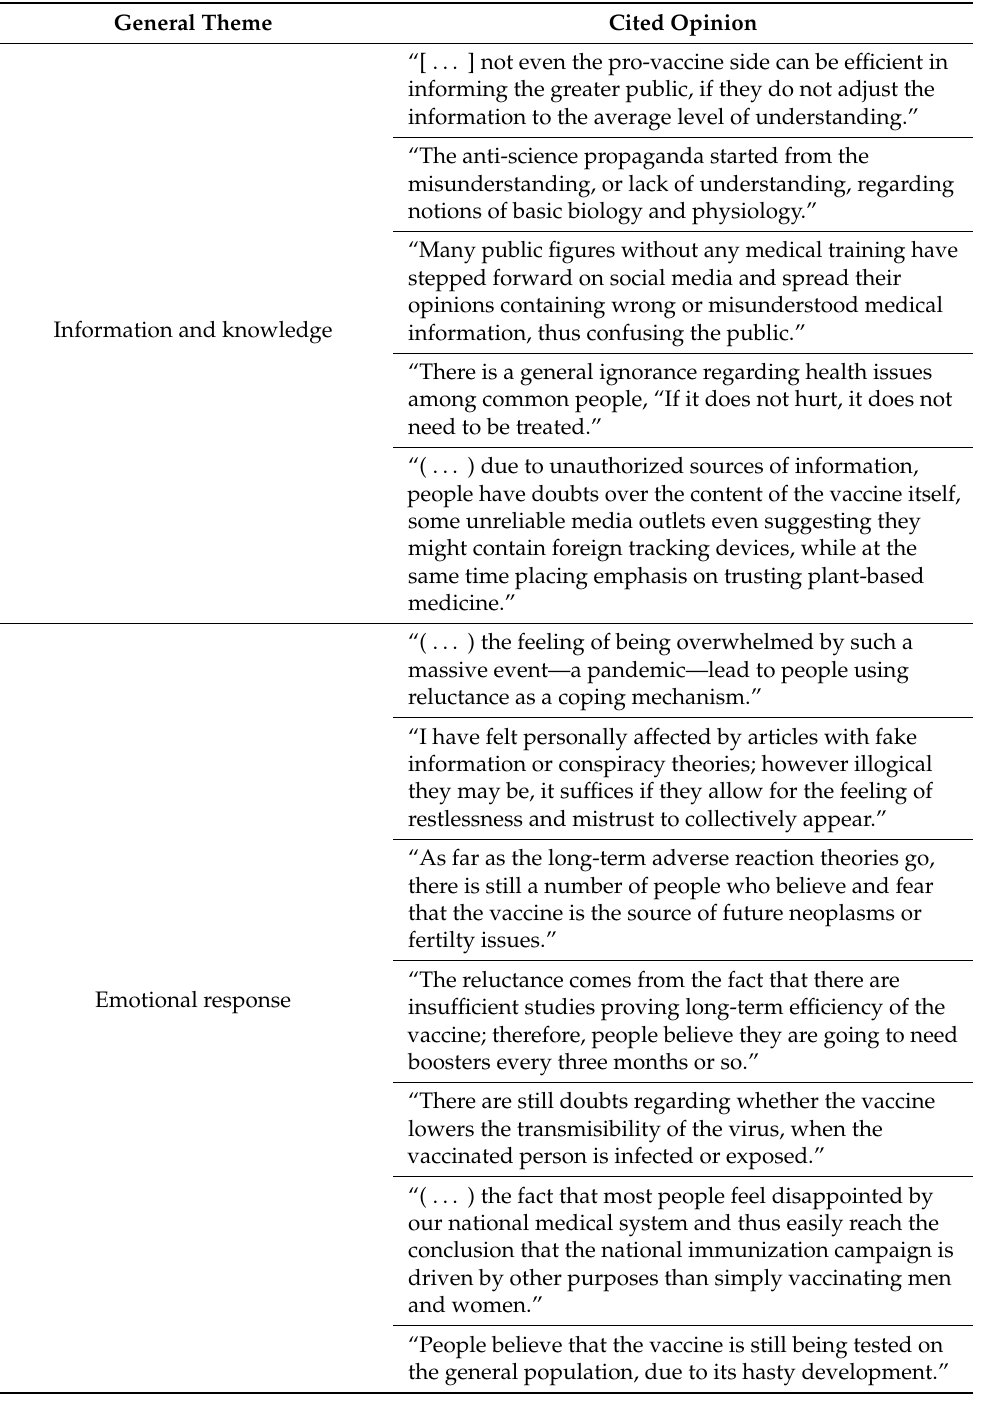
Table 2. Cited opinions regarding the general population’s reasons for refusing EU-approved COVID- 19 vaccines. Short extracts from the answers provided to the question “What do you think the main reasons behind vaccine hesitancy in the general population are?”, grouped according to relevant general